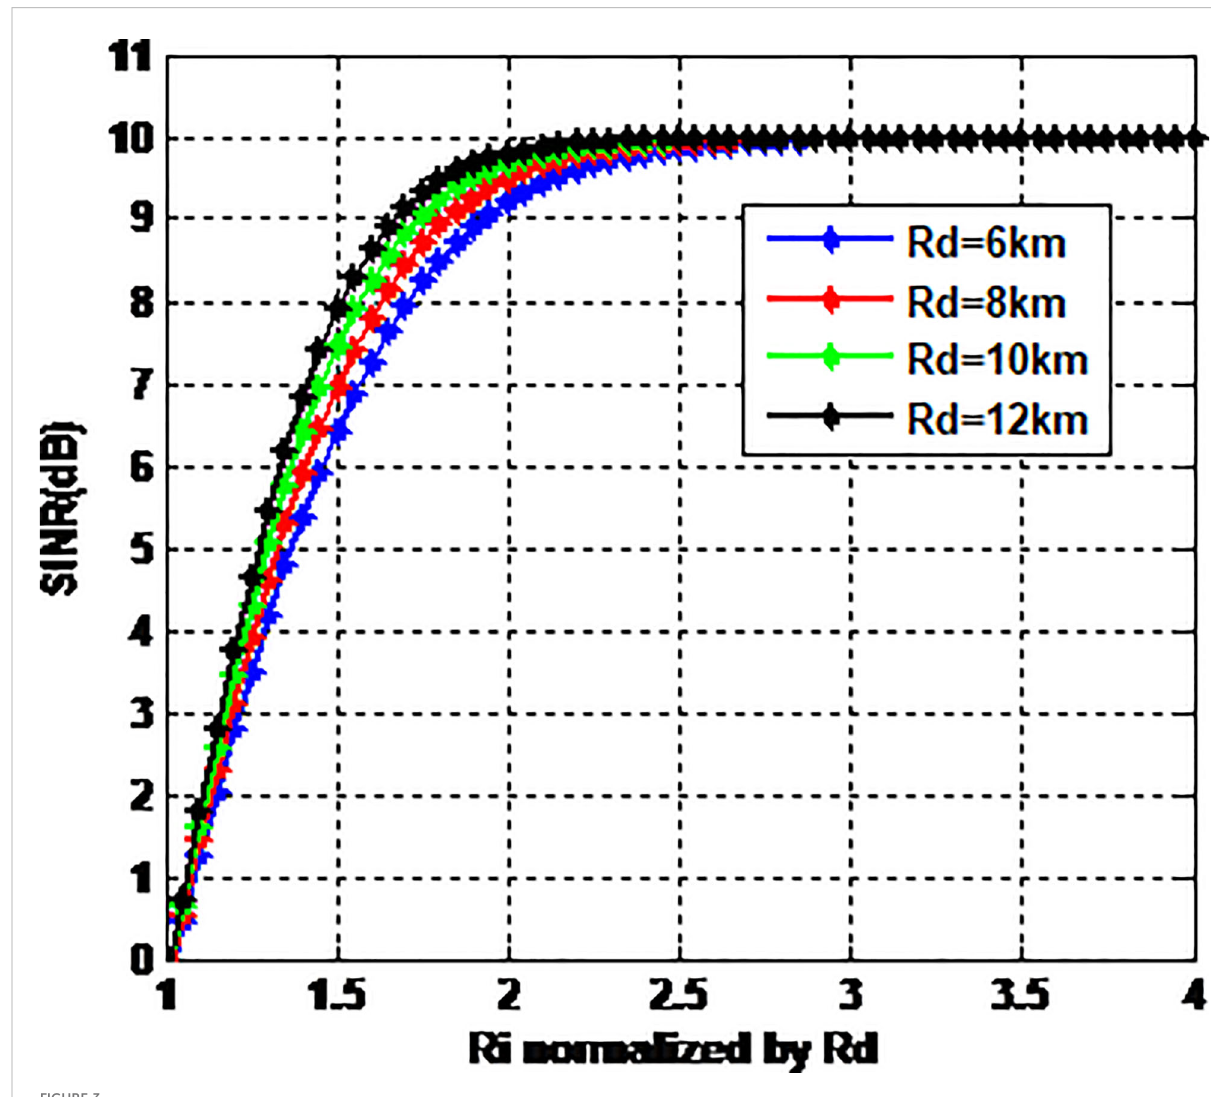
FIGURE 3 SINR versus interference